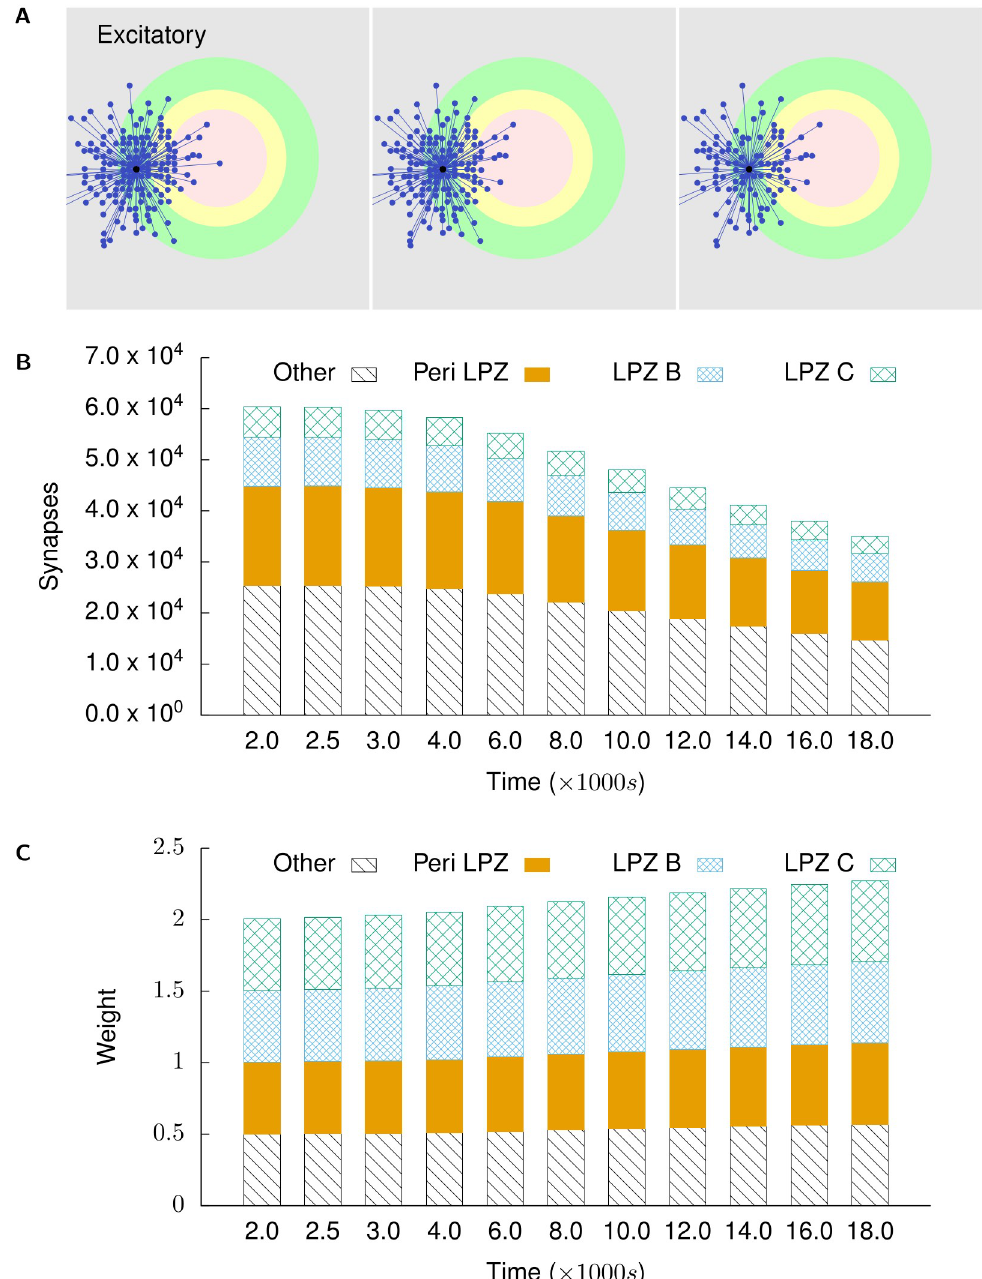
Fig 8. Excitatory projections to excitatory neurons in the peri-LPZ. (A) shows incoming excitatory projections to a randomly chosen neuron in the peri-LPZ at different stages of our simulations. From left to right: t = 2000 s, t = 4000 s, and t = 18,000 s. (B) shows the total numbers of incoming excitatory projections to neurons in the peri-LPZ from different regions at different points in time. (C) shows the mean weight of projections received by neurons in the peri-LPZ from different regions at different points in time. In contrast to neurons in the LPZ, neurons outside the LPZ experience an increase in activity in our simulations. As a result of our growth rules, these neurons lose excitatory inputs.